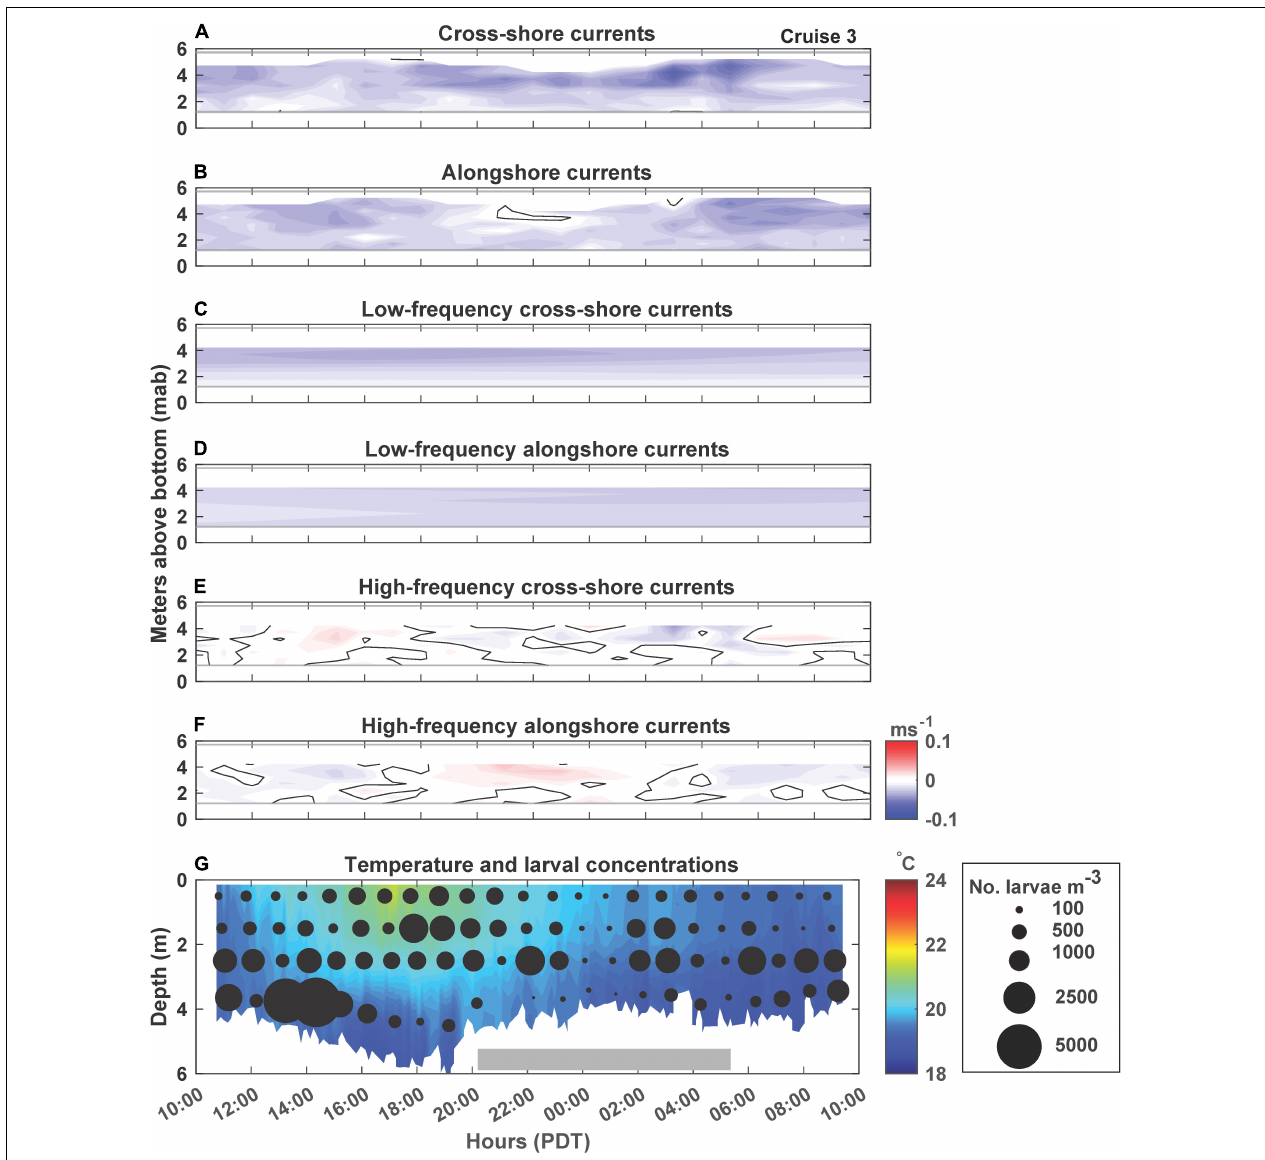
FIGURE 4 | Cruise 3 (June 7–8, 2018) currents, temperature and larval concentrations. Figure details are the same as Figure 2 . Note that C. fissus larval concentration circles are scaled differently than for Cruises 1, 2, and 4 due to high larval